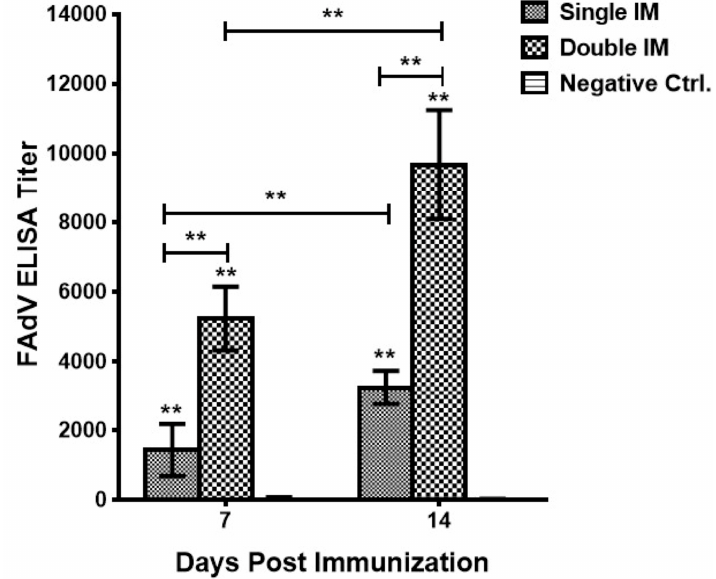
Figure 1. Fowl adenovirus (FAdV)-specific antibody responses induced 7 days and 14 days post single and double immunization. Chickens in the Single immunization (IM) group produced higher antibody response than the Negative Ctrl. group ( p < 0.01), and the double immunization boosted the immune response more than single immunization ( p < 0.01). Significant differences between different experimental groups were evaluated at (** p < 0.01).